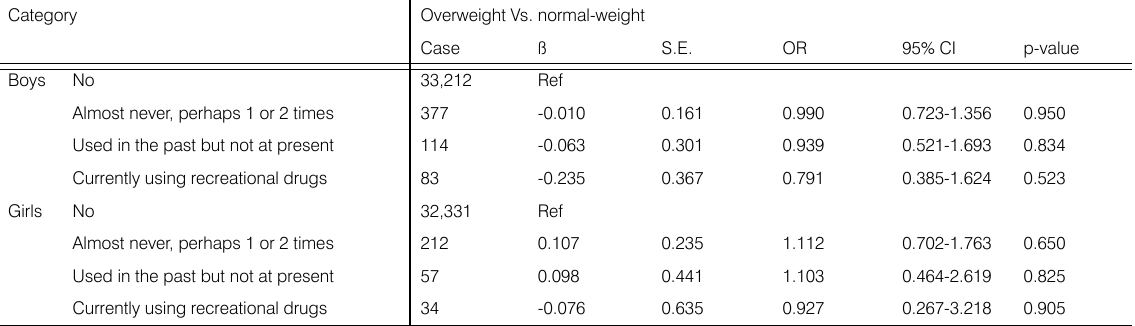
Table 2. The multivariable logistic regression analyses of recreational drug use for the overweight and normal-weight groups in Korean adolescents.